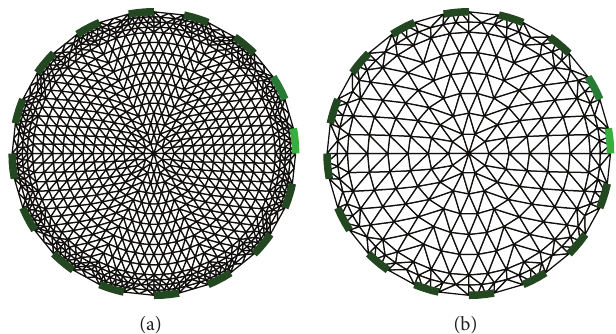
Figure 1: The forward and inverse models. (a) the forward model with 1968 triangulation elements; (b) the inverse model with 492 elements.